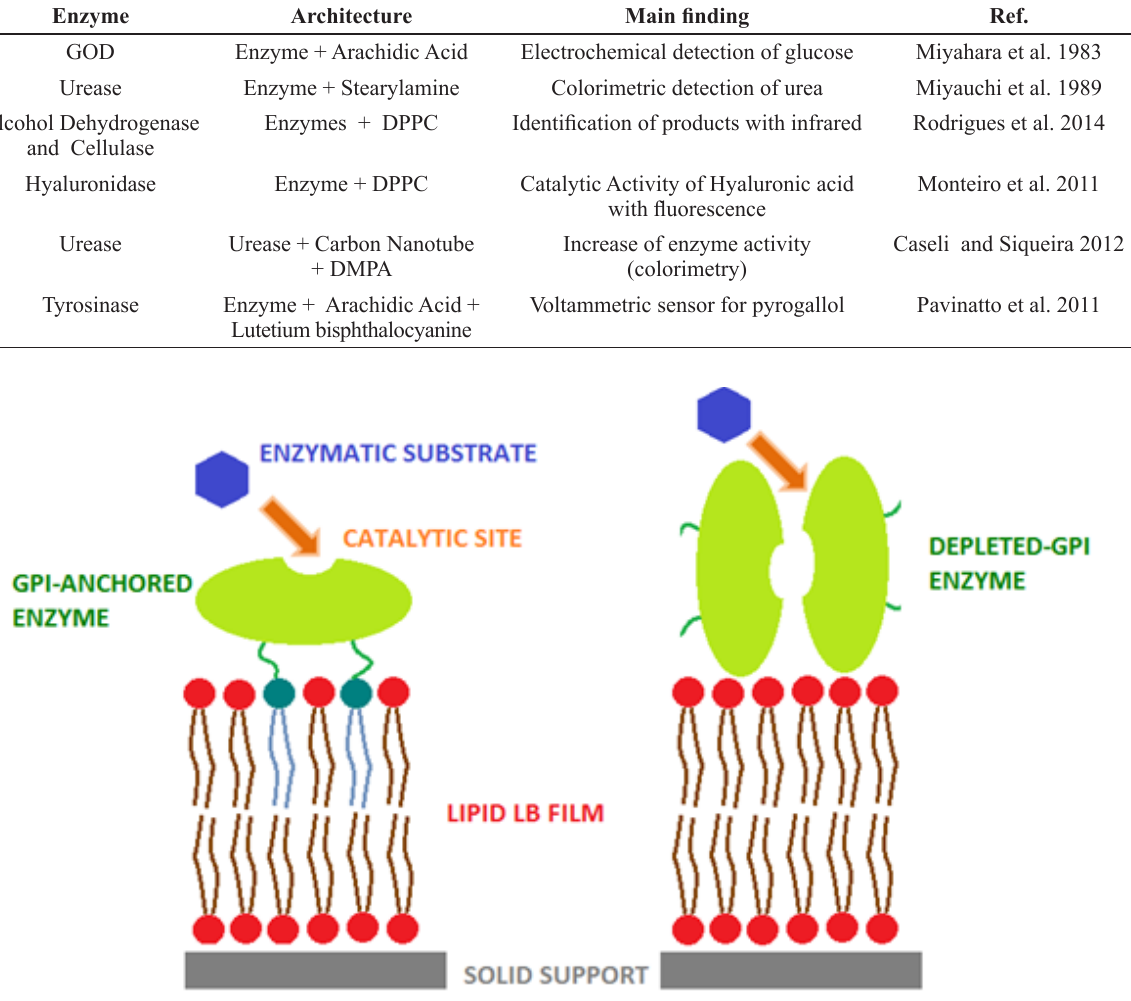
Figure 2 - Scheme for the immobilization of alkaline phosphatase on DMPA LB films and their effect on the access of the substrate to the catalytic site. At left the enzyme contains the GPI anchor intact, and at right the GPI anchor is